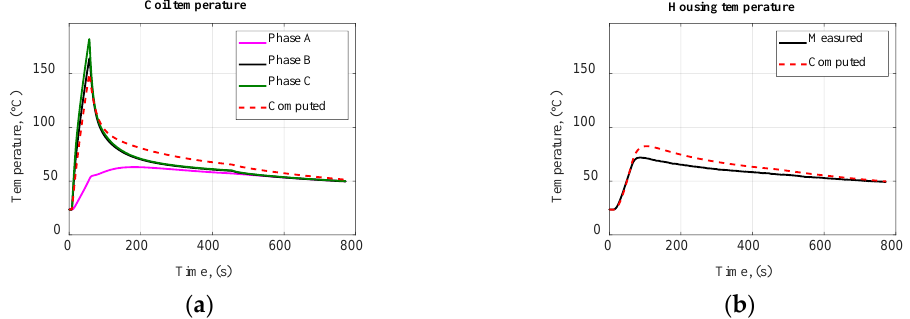
Figure 10. Measured and computed temperatures in the three phases ( a ) and in the housing ( b ) for the short-time pulse test in configuration A.